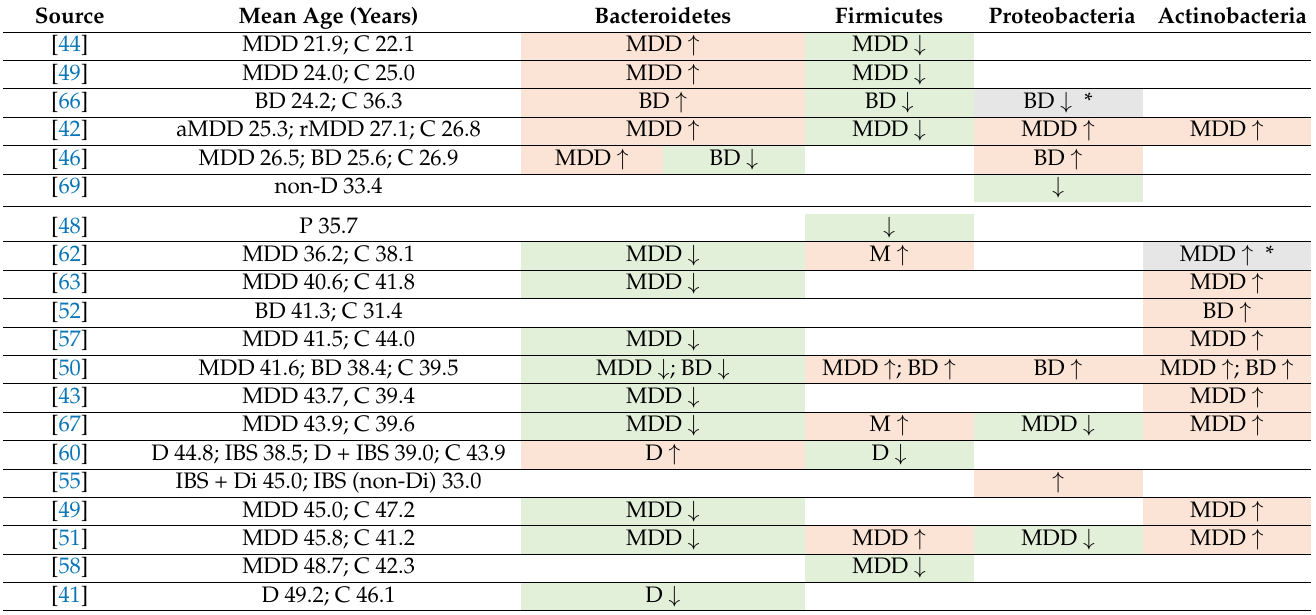
Table 2. Different abundance on phylum level, with the studies sorted by age of the diseased subjects.